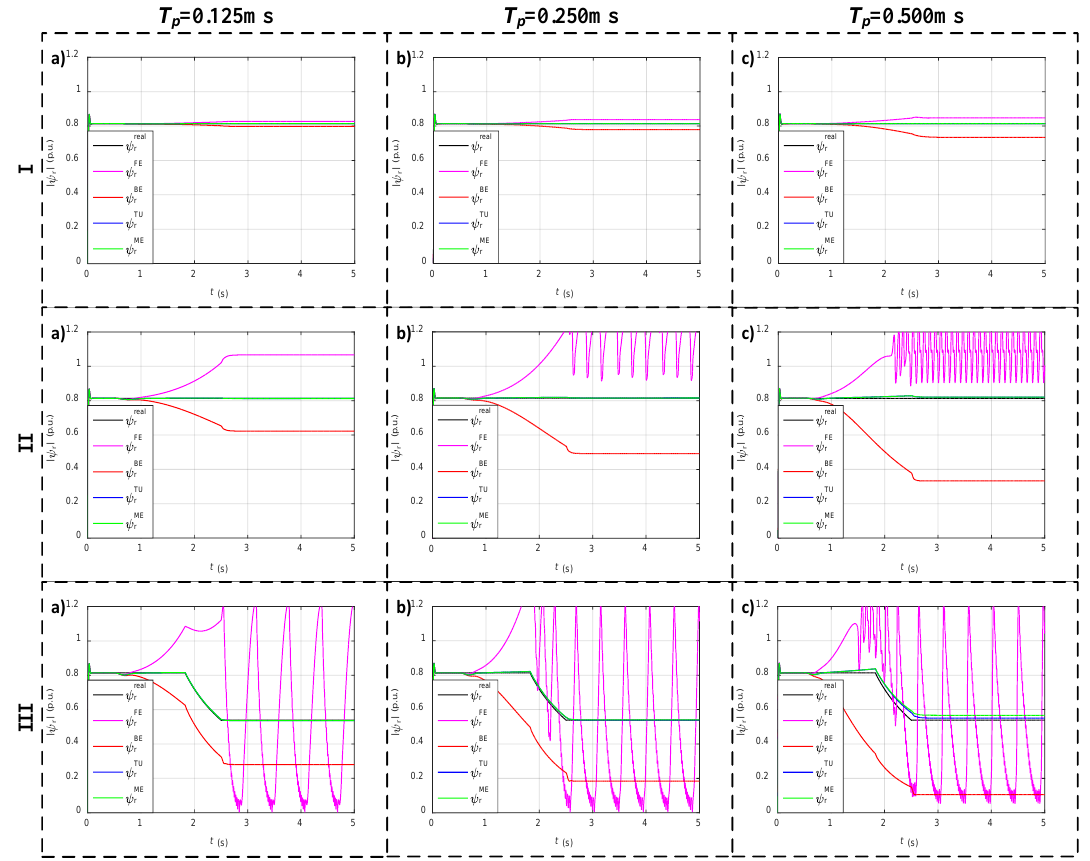
Figure 7. Rotor flux magnitude estimation after MRAS CC discretization using four numerical integration methods for three different sampling steps: ( a ) T p = 0.125 ms , ( b ) T p = 0.25 ms , ( c ) T p = 0.5